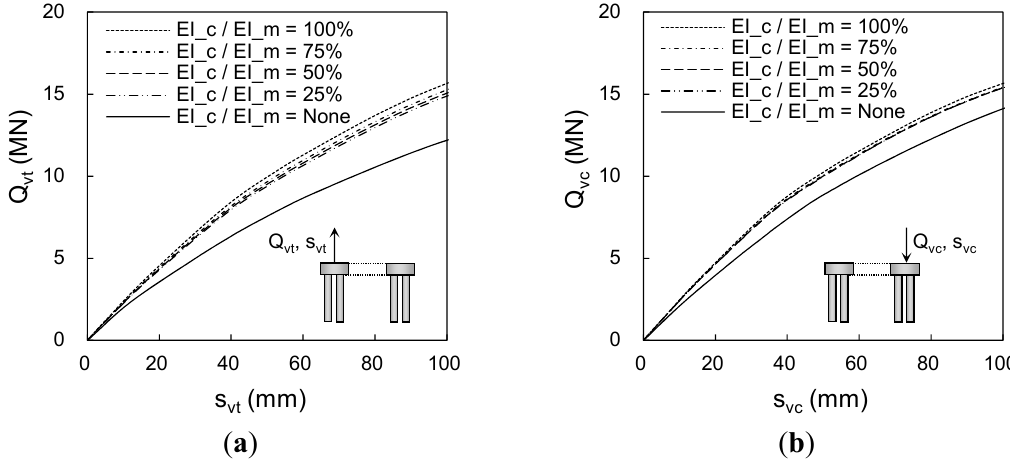
Figure 10. Load-displacement curves with different connection beam of conditions: ( a ) uplift foundation and ( b ) compressive foundation